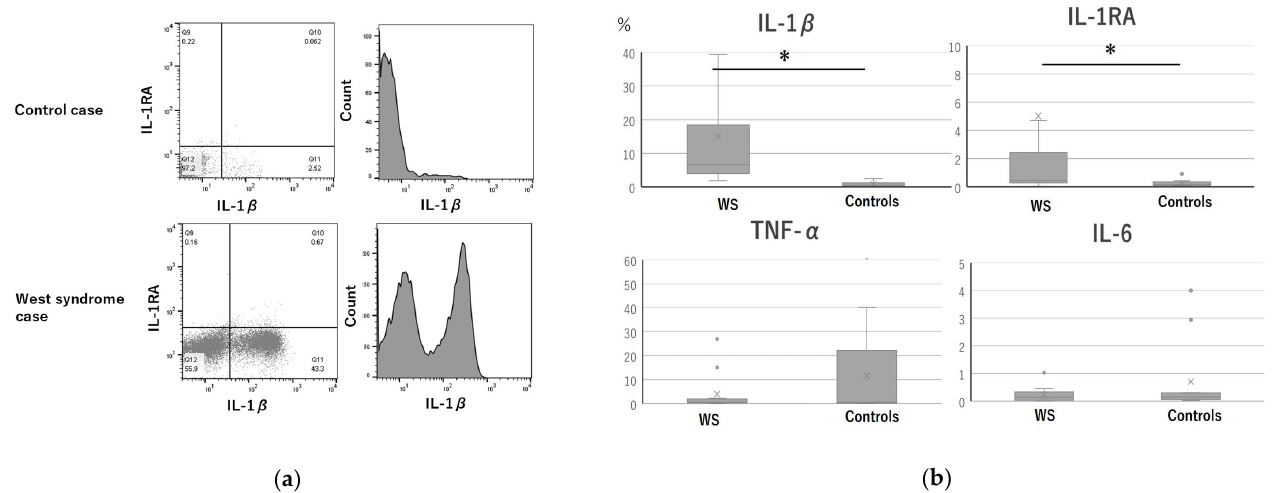
Figure 1. ( a ) An example of a plot of flow cytometry results for IL-1 β and IL-1RA and the histogram of CD14-positive monocytes, analyzed by flow cytometry in patients with West syndrome and the control group. An increase in IL-1 β production could be observed in patients with West syndrome. IL; interleukin, WS; west syndrome, TNF; Tumor necrosis factor ( b ) Intracellular cytokine expression in monocytes. Blood samples were obtained from 13 patients with West syndrome and 10 healthy controls. The boxplot extends from the 25th to the 75th percentile. The whiskers represent the Table 2. Comparison of intracellular cytokine levels between patients with West syndrome and the maximum value on the top and the minimum value on the bottom. “ × ” represents the mean, and the control participants. line in the middle box represents the median. * p <